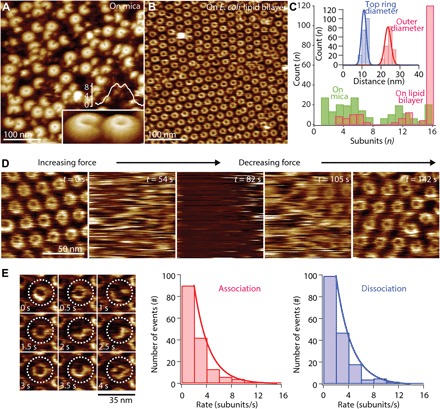
HS-AFM of MPFN2 pre-pore structure and assembly.(A) HS-AFM high-resolution image of mPFN2 on mica. Most of the mPFN2 oligomers are incomplete crescent-shaped assemblies, likely due to restricted lateral diffusion on mica necessary for full assembly of rings. The individual subunits can be distinguished (inset image). The inset section profile shows that pre-pore rings have a height of ~8.5 nm, which is consistent with the cryo-EM pre-pore model. (B) HS-AFM image of mPFN2 on an E. coli lipid bilayer. Essentially all mPFN2 oligomers are complete rings that assemble into a close-packed hexagonal lattice. (C) Histogram analysis of mPFN2 assembly on mica and on an E. coli lipid bilayer. On mica, mPFN2 displays a wide range of arc angles from one subunit to a full ring. On the lipid bilayer, ≥80% of mPFN2 molecules form complete ring assemblies, with a top ring diameter of 11.2 ± 0.9 nm and an outer diameter of 23.8 ± 1.2 nm (inset). (D) HS-AFM images of mPFN2 oligomers on an E. coli lipid bilayer (t = 0 s and t = 142 s) exposed to HS-AFM tip force induced removal (t = 54 s), giving access to an empty bilayer (t = 82 s) followed by assembly recovery (t = 105 s), in agreement with bilayer surface–associated pre-pores. (E) HS-AFM images (frame acquisition speed: 500 ms) and histogram analysis of mPFN2 subunit association (2.4 s−1) and dissociation (2.3 s−1) rates. Around 10 association/dissociation events were measured for identical mPFN2 oligomers in a single time frame, and more than 15 oligomers were recorded (total events, both >150). Histograms of association and dissociation rates were fit to a single exponential decay function. Full rings, where all subunits have neighbors on both sides, are stable over extended periods of time.